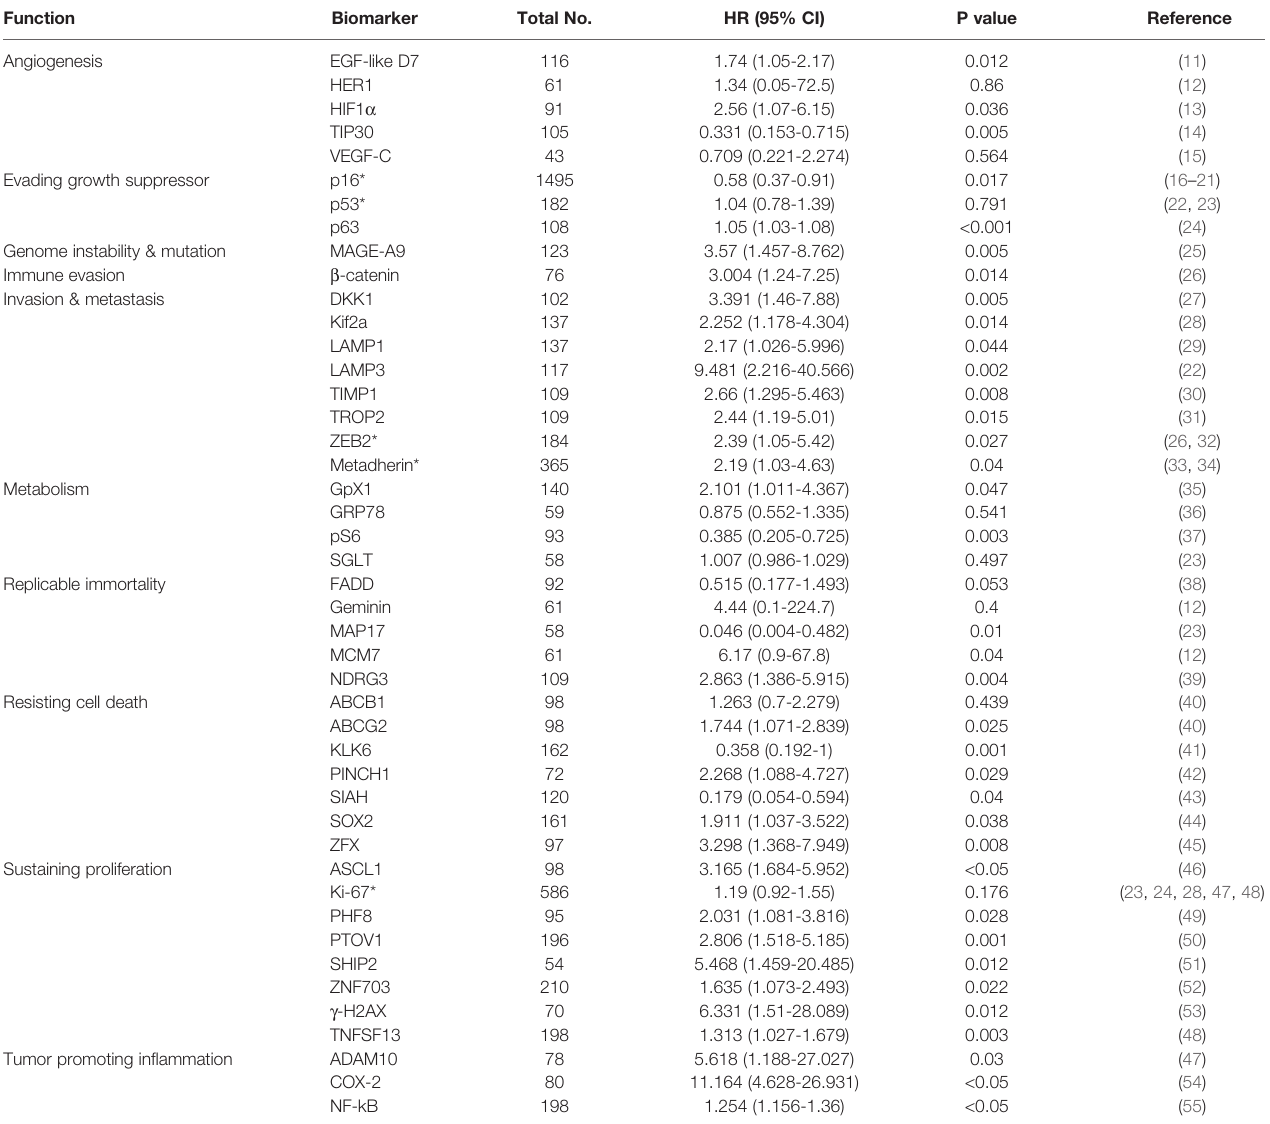
TABLE 1 | IHC biomarkers related to overall survival of laryngeal or pharyngeal SCC. Function Biomarker Total No.